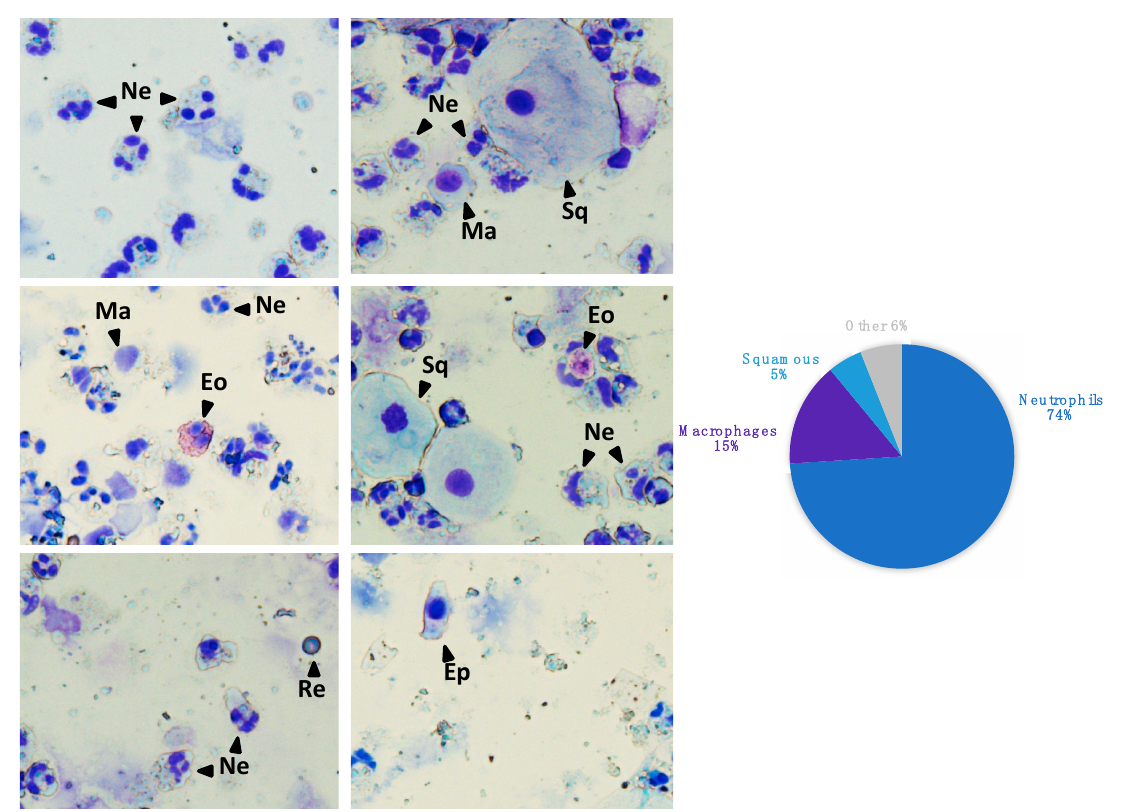
Figure 1. Cell count of sputum samples from the MethylBiomark cohort. Neutrophils (Ne) were dominant, followed by macrophages (Ma), small percentages of buccal squamous cells (Sq), and other cell types—eosinophils (Eo), red blood cells (Re), epithelial cells (Ep), and lymphocytes. Cytospins were stained with Kwik Diff.